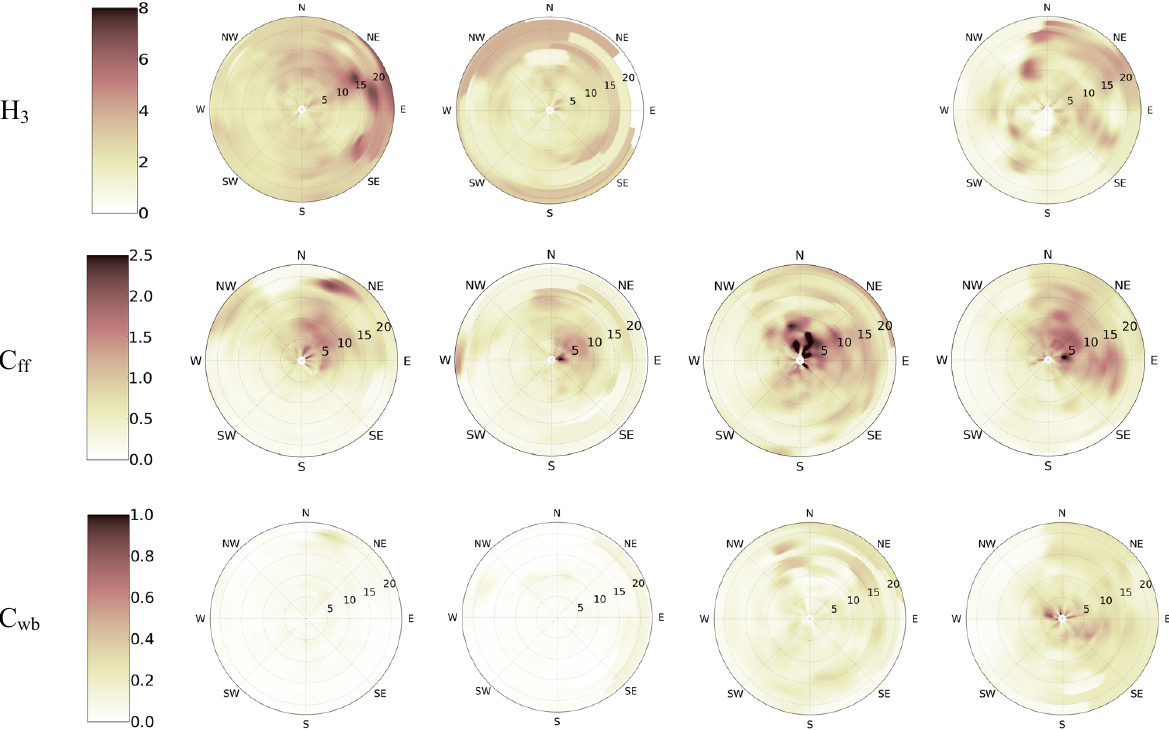
Figure 8. Seasonal NWR plots for the major components of PM 1 and gaseous ammonia. Radial and tangential axes represent the wind direction and speed (kmh − 1 ), respectively.